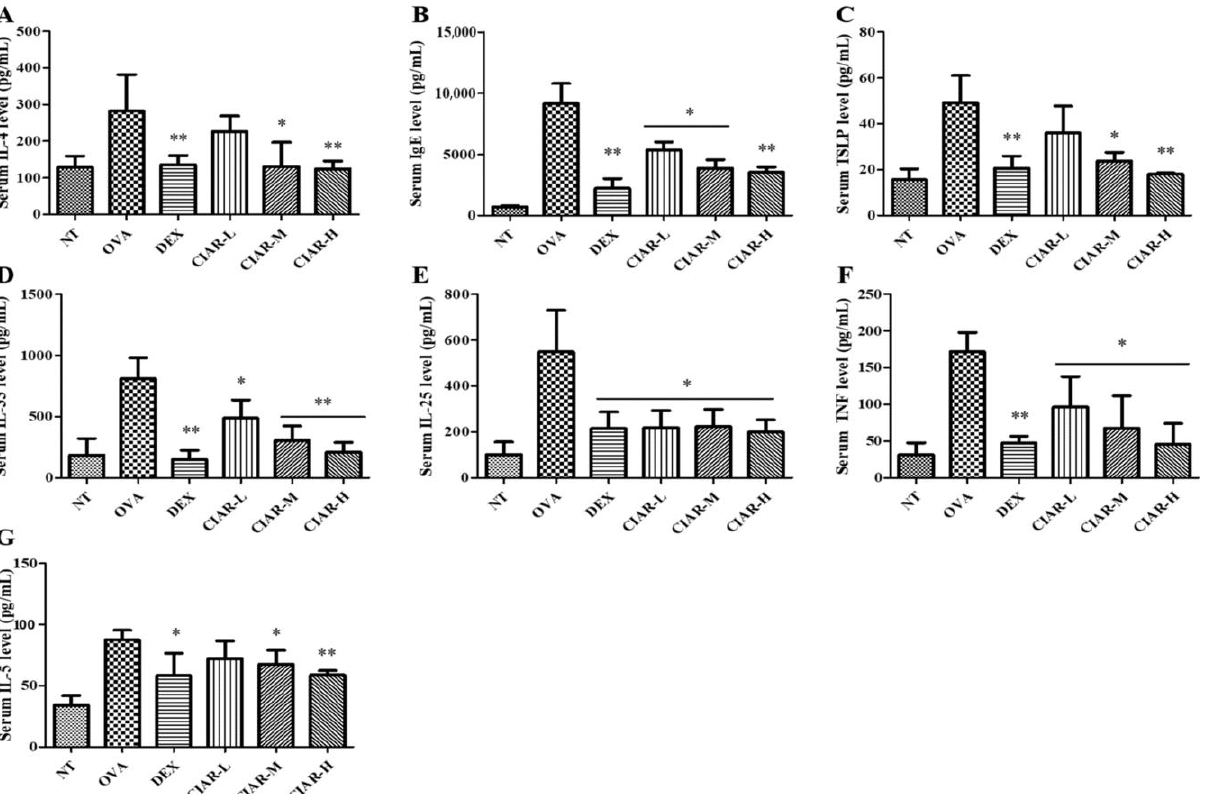
Figure 2. Effects of Th-2 related signal level of CIAR on blood of mice with ovalbumin-induced allergic rhinitis. Effect on ( A ) IL-4, ( B ) IgE, ( C ) TSLP, ( D ) IL-33, ( E ) IL-25, ( F ) TNF, and ( G ) IL-5 levels in serum samples. Data are shown as the mean ± SE. Significant differences are indicated as * p < 0.05 and ** p < 0.01, compared to the OVA group. NT—normal mice; OVA—OVA-exposed mice;